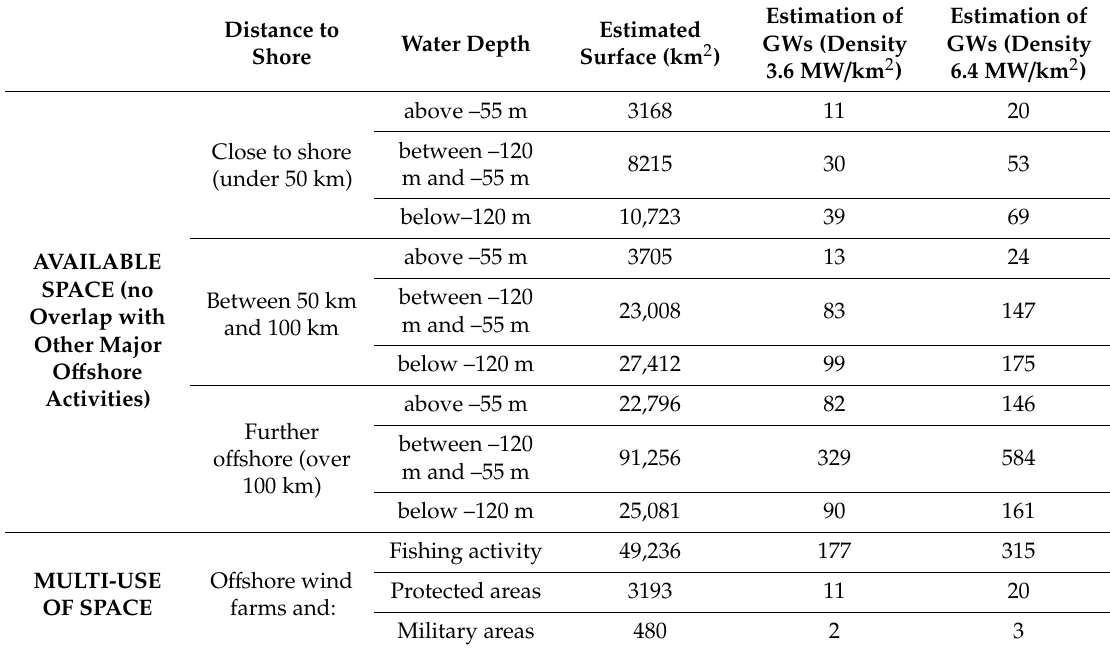
Table 7. Available space—Scenario